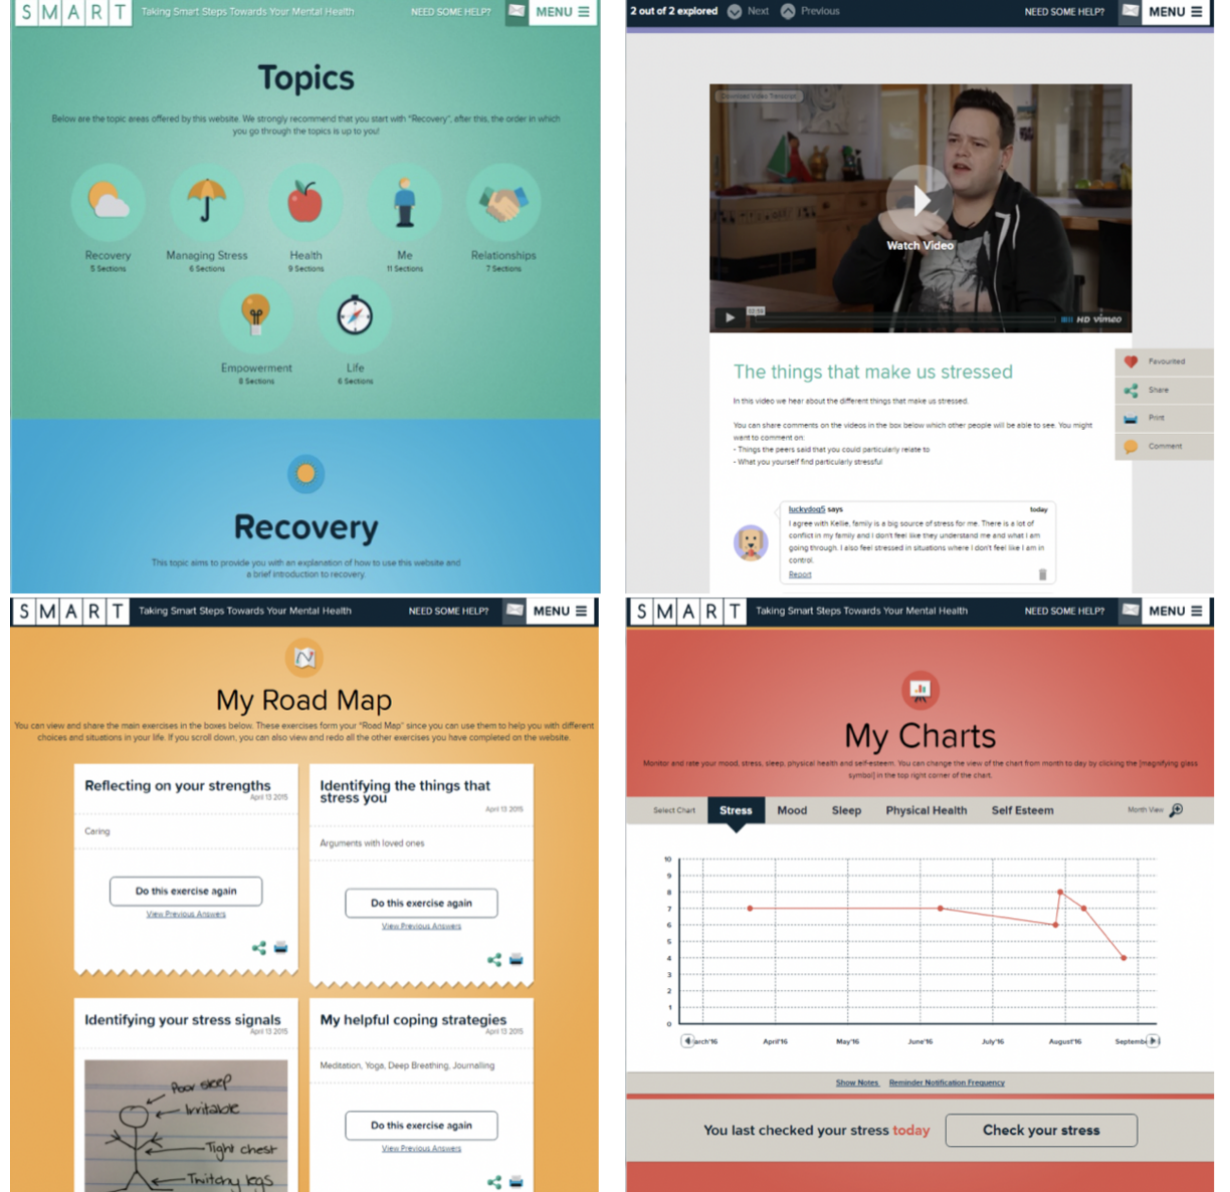
Figure 1. Example screenshots from the Self-Management and Recovery Technology